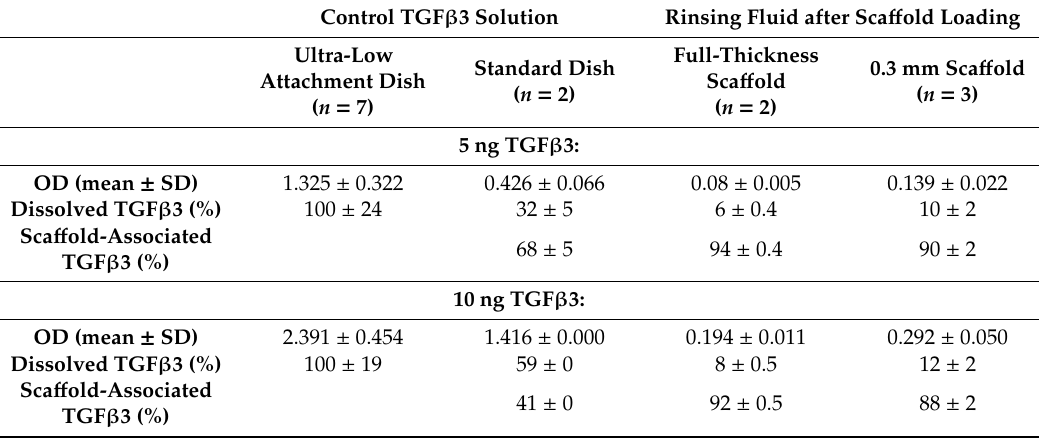
Table 1. Quantification of TGF β 3 by ELISA. Optical densities (OD) of the TGF β 3 control solutions after 24 h incubation in ultra-low attachment or standard dishes and OD of the rinsing fluids obtained 24 h after sca ff old loading. The percentages of dissolved and surface-trapped / sca ff old-associated TGF β 3 were calculated based on the control measurements after incubation in ultra-low attachment